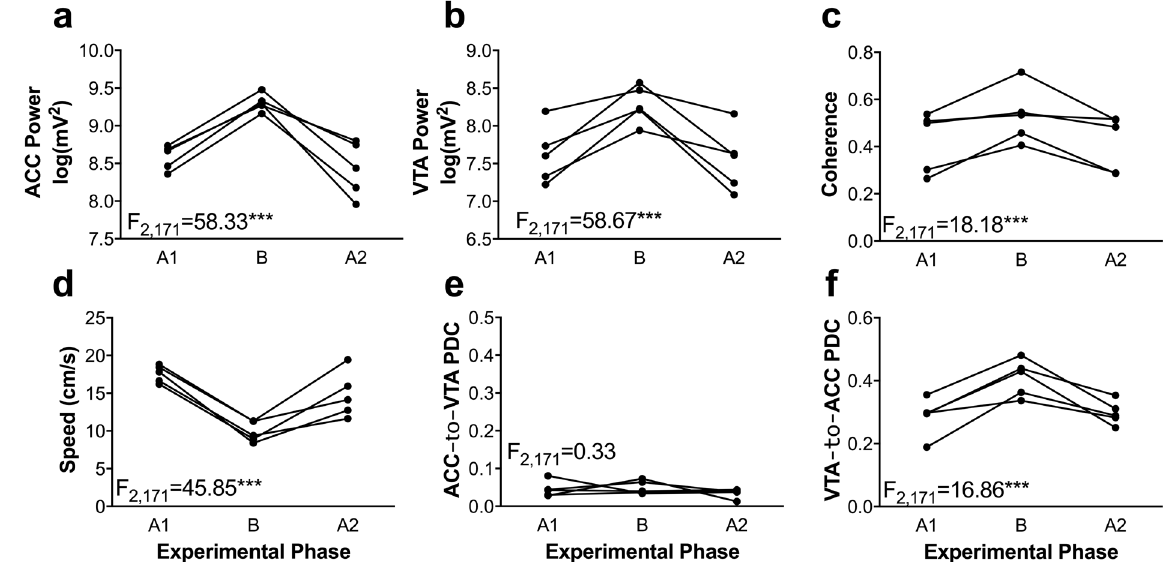
Figure 8. Experimental phase dependent changes vertex behaviour and electrophysiology during instruction trials. Here, we manipulated whether instruction trials forced animals towards the rewarded maze arm (phases A1 and A2) or towards the unrewarded, barrier-containing maze arm (phase B). Vertex ACC power ( a ), VTA power ( b ), ACC-VTA coherence ( c ), and VTA → ACC PDC ( f ) were greater during instruction trials which forced animals towards unrewarded, barrier-containing maze arms as compared to instruction trials which forced animals towards rewarded maze arms. Correspondingly, animals were slower to leave the vertex during instruction trials which forced animals towards unrewarded, barrier-containing maze arms as compared to their vertex running speeds during instruction trials which forced them towards rewarded, no-barrier maze arms ( d ). No differences in ACC → VTA PDC ( e ) were detected across the phases. Data were analysed according to the normalisation and regression parameters described for each dependent measure in the main text. Data are presented as the grand means of each animal such that each marker corresponds to the mean of one animal on the un-normalised (raw) scale of each dependent measure in one experimental phase. The lines connecting the markers indicate the change in the mean choices of individual